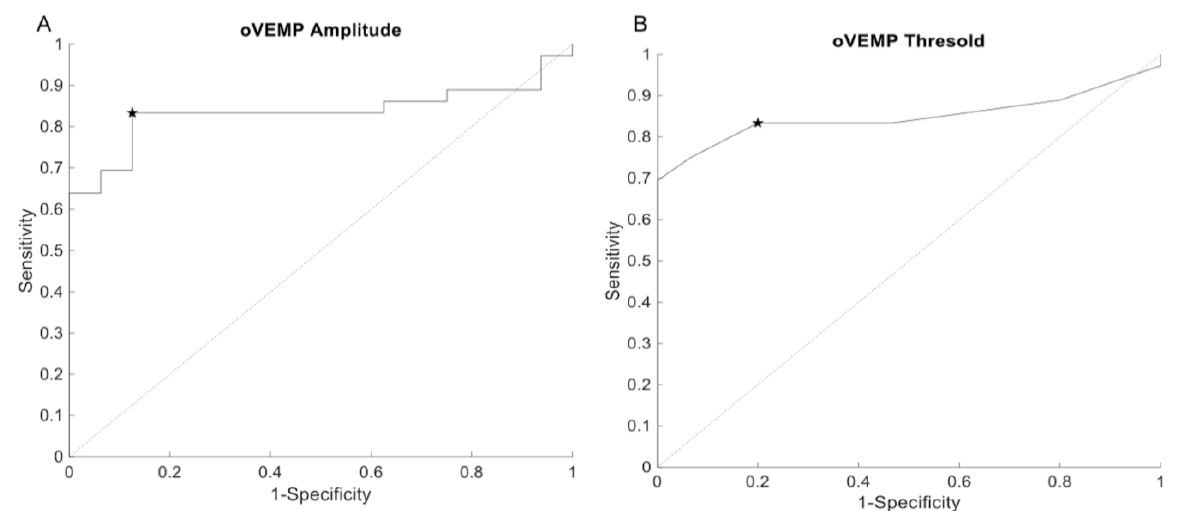
Figure 6. ROC curve representing the diagnostic value of oVEMP (500 Hz) amplitude ( A ) and oVEMP (500 Hz) threshold ( B ). The star symbol represents sensitivity and specificity for the given cutoff value.